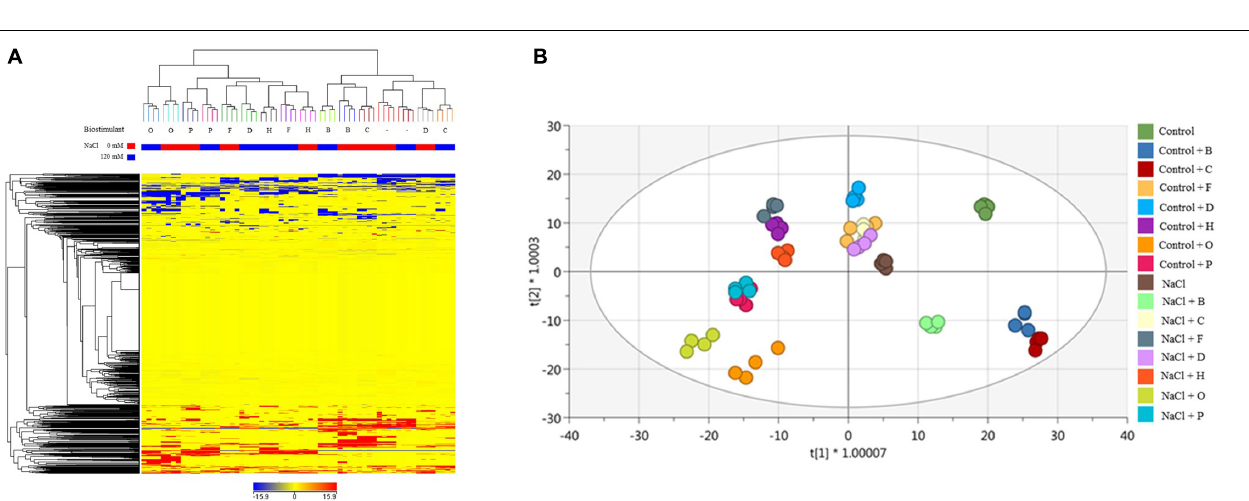
(VIP score > 1.20). A total of 310 (salinity,